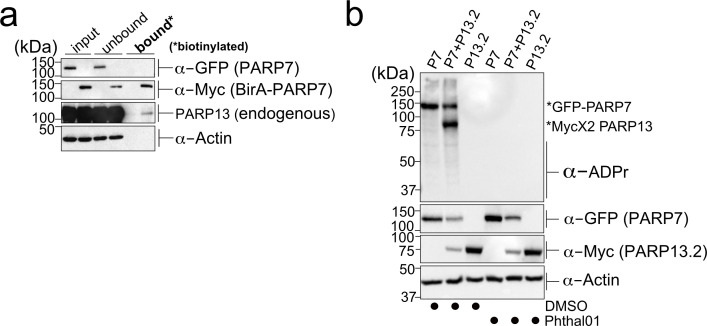
PARP-13 interacts with and is MARylated by PARP-7 in cells.(a) PARP-7 interacts with endogenous PARP-13 (constitutive isoform PARP-13.1) in cells as shown by proximity labeling. HEK 293 T cells were transfected with Myc-BirA*-PARP-7. Biotin (50 μM) was added to induce biotinylation of Myc-BirA*-PARP-7 interactors. Biotinylated proteins were enriched using Neutravidin agarose. Proteins were resolved by SDS-PAGE and were detected by Western blot using antibodies against GFP, Myc, PARP-13, and actin. Representative figure of data collected over three biological replicates. (b) PARP-7 MARylates PARP-13.2 in cells. GFP-PARP-7 and MycX2-PARP-13.2 were co-expressed in HEK293T cells. Cells were treated overnight either with DMSO or with Phthal01 (1 μM). Proteins were resolved by SDS-PAGE and were detected by Western blot using antibodies against ADP-ribose (ADPr), GFP, Myc, and actin. Representative figure of data collected over three biological replicates.Figure 3—source data 1.In vitro IC50 Data for Phthal01 against PARP family members.Phthal01 (6-(4-(2-fluoro-5-((4-oxo-3,4-dihydrophthalazin-1-yl)methyl)benzoyl)piperazin-1-yl)nicotinonitrile) was tested against all active PARP family members using an ADP-ribosylation plate assay developed in our lab (Kirby et al., 2018). IC50 Data represents ± SEM from at least two biological replicates.